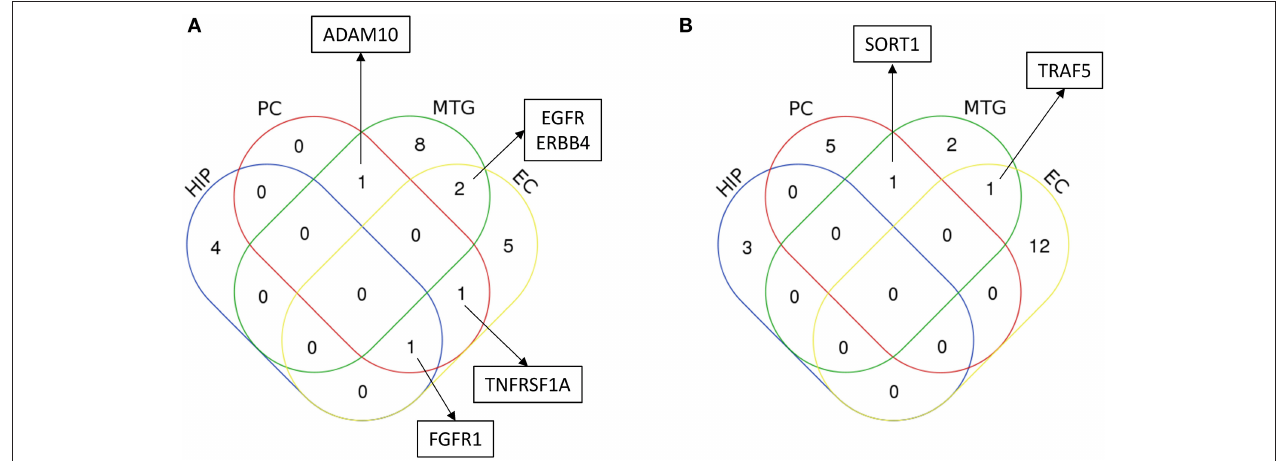
FIGURE 8 | Characterization of common and unique region specific inflammatory regulators in AD brain inferred from the computational analysis. The figure shows the Venn diagram comparing the inferred regulators of inflammation (A) upregulated in AD, and (B) downregulated in AD, for four major regions AD patients analyzed in this study. These regions are hippocampus (HIP), posterior cingulate cortex (PC), middle temporal gyrus (MTG) and entorhinal cortex (EC). Regulators (only considering receptors/ligands) found to be important for more than one brain regions are highlighted in the box. In addition, in the case of upregulated signaling subnetworks, EGFR signaling was identified for primary visual cortex and superior frontal gyrus in addition to its role in middle temporal gyrus and entorhinal cortex, and FGFR1 signaling was identified for primary visual cortex. In the case of downregulated signaling subnetworks, PPP2CA was found to be commonly present in primary visual cortex and superior frontal